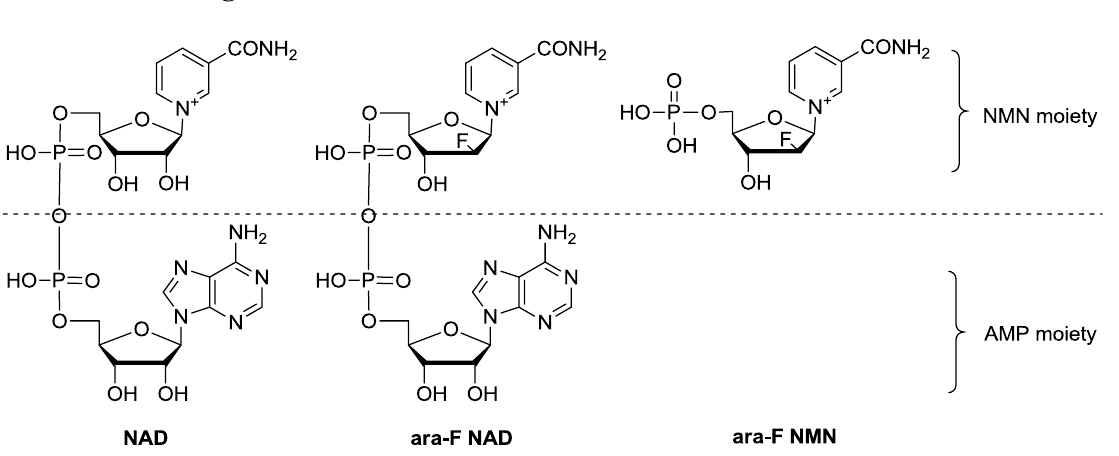
Figure 1. Structures of NAD, ara-F NAD and ara-F